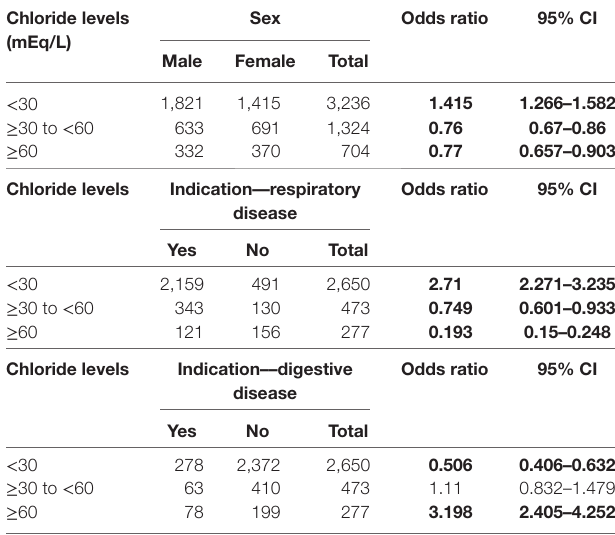
Table 1 | Association between sweat chloride levels, sex of the subject, and reason for indication of sweat